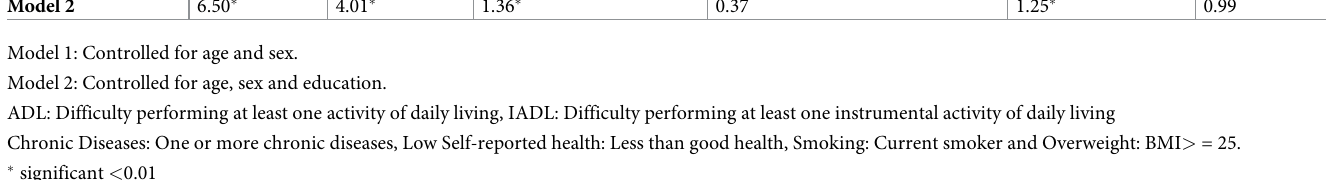
In this study, we examined differences in functioning ability and health between immigrants and Norwegian aged 45 years and above. When health of elderly people deteriorates, it increases their care needs and their dependance on the health services, which places burden on Table 2. Odds ratios of functionality, health problems and risk factors among immigrants compared to Norwegians, controlled for age, gender and education. ADLs IADLs Chronic